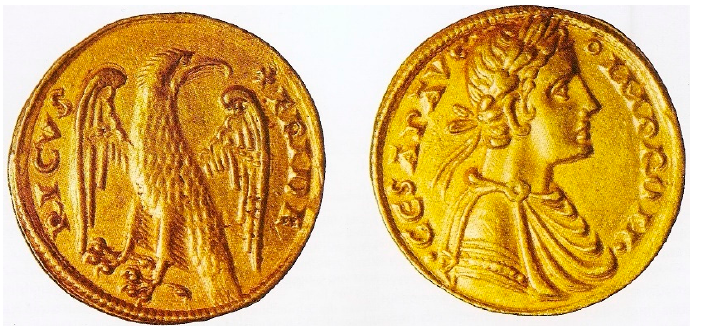
Figure 3. Augustale of Frederick II of Hohenstaufen, obverse and reverse sides of a gold coin, 1231–1250. Naples, Museo Archeologico Nazionale, Collezione Fiorelli, no. 1127. Image published in [12] (Figure 23).